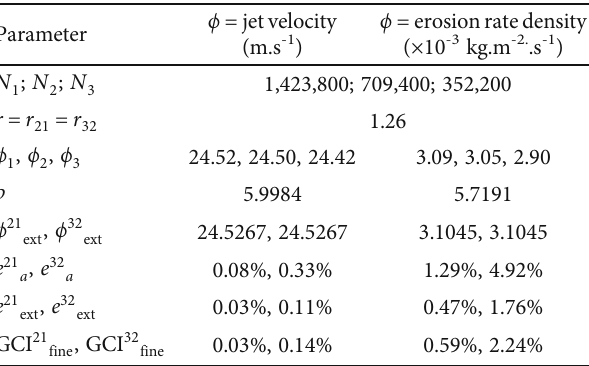
Table 2: Mesh discretisation error summary based on Celik et al. [28].